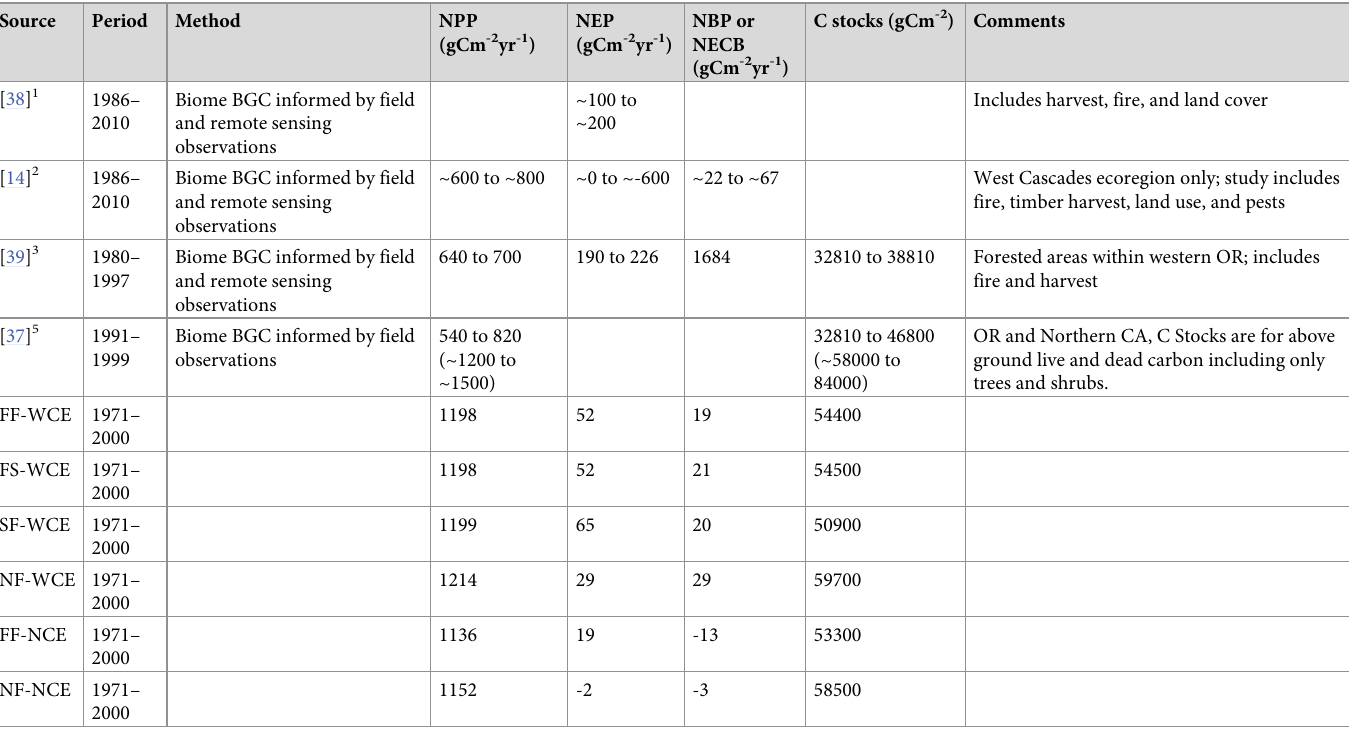
Table 4. Carbon flux and pool values from other studies and the current study.